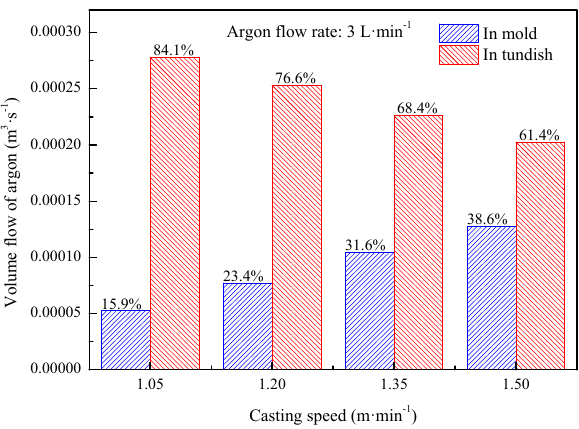
Figure 12. Volume flow distribution of argon under different casting speeds.